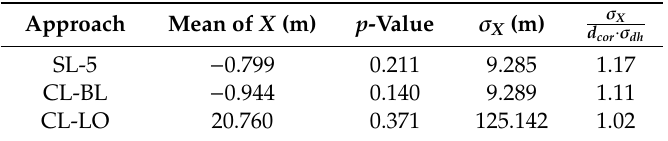
Table 4. Summary of mean and standard deviation of X, p -value of t-test and revealed value of σ X for the three tested void filling